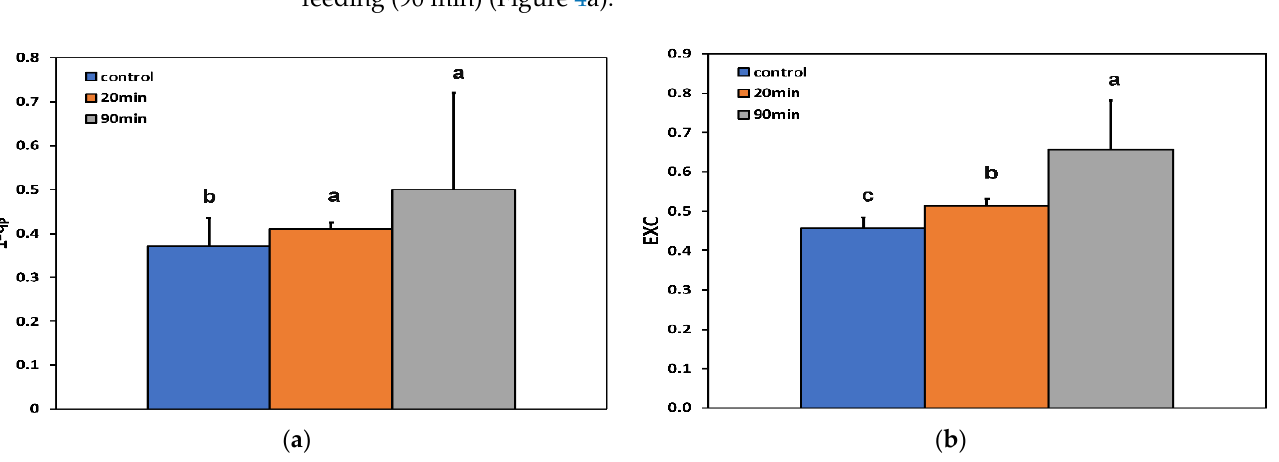
Figure 5. Typical colour-coded images of Φ PS ΙΙ , Φ NPQ , Φ NO , and q p , of a potato leaflet before insect feeding ( upper row ) and immediately after 90 min feeding ( second row ) by Halyomorpha halys . The areas of interest (AOIs) that were measured are shown in circles with values in red labels. The whole leaflet values (average ± SD) are given with the white numbers. In the image of Φ PS ΙΙ after 90 min feeding; asterisk indicates Φ PSII value 0.064. The colour code at the bottom ranges from pixel values 0.0 to 1.0.